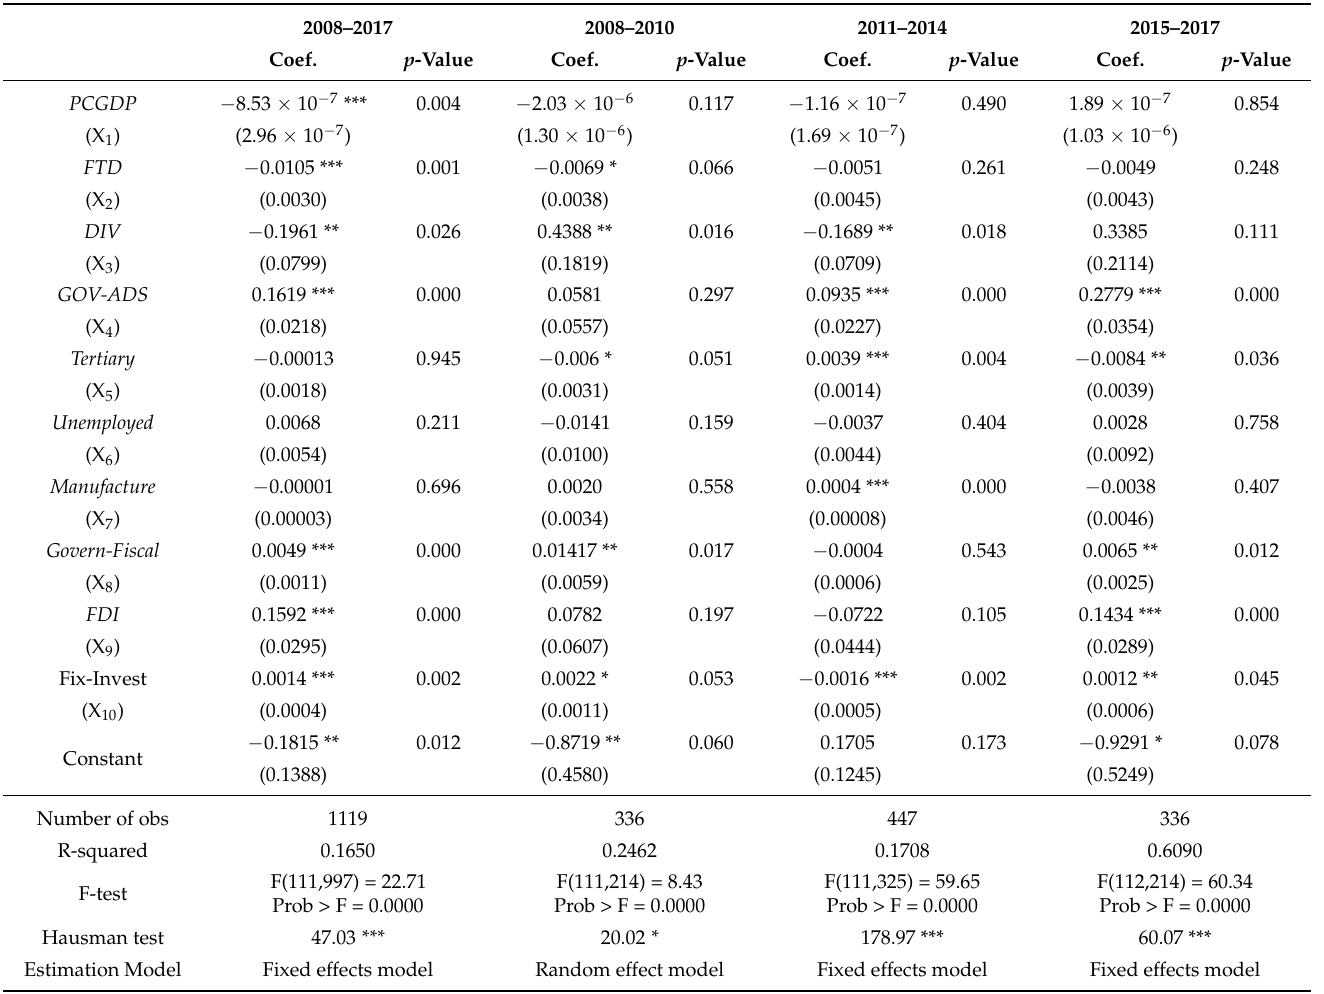
Table 1. The Regression results of the main influential factors on regional economic